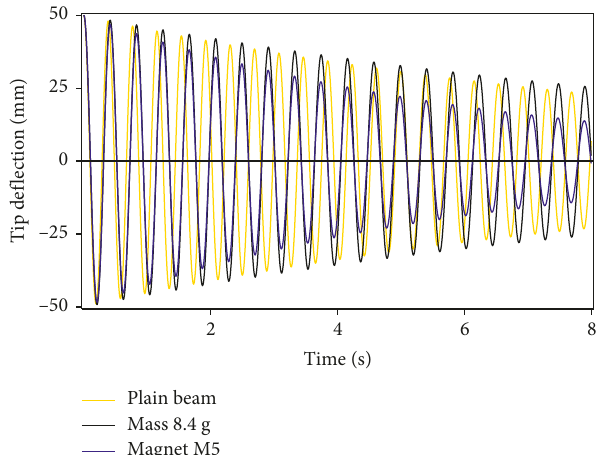
Figure 12: Tip deflection of the beam without the magnet (gold), with an artificial mass equal to the mass of the magnet (black) and with the 5mm neodymium magnet (blue); MRE 1A.